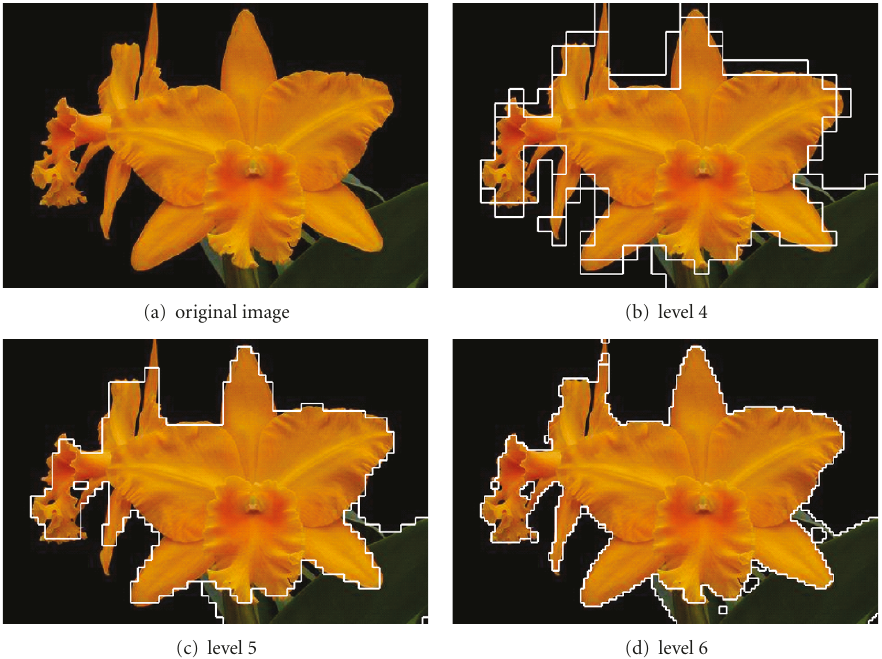
Figure 7: Segmentation results of Orchid at 3 di ff erent resolution levels.